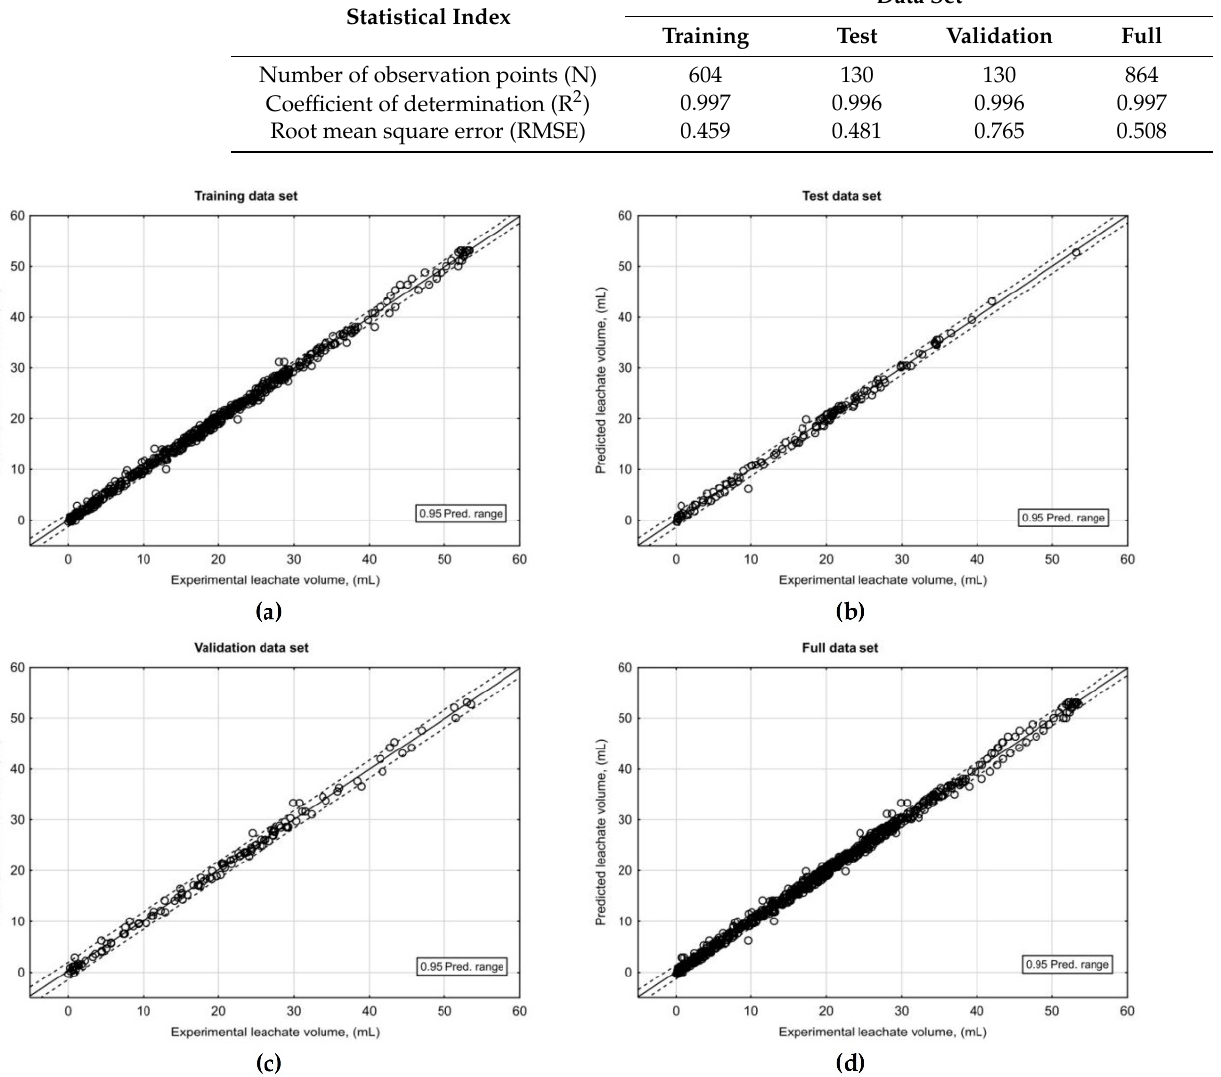
Figure 6. Predictability of ANN-MLP model of water–fat serum release from pasta filata cheese. The solid line represents a perfect fit between experimental and predicted values for ( a ) training, ( b ) test, ( c ) validation and ( d ) full datasets.